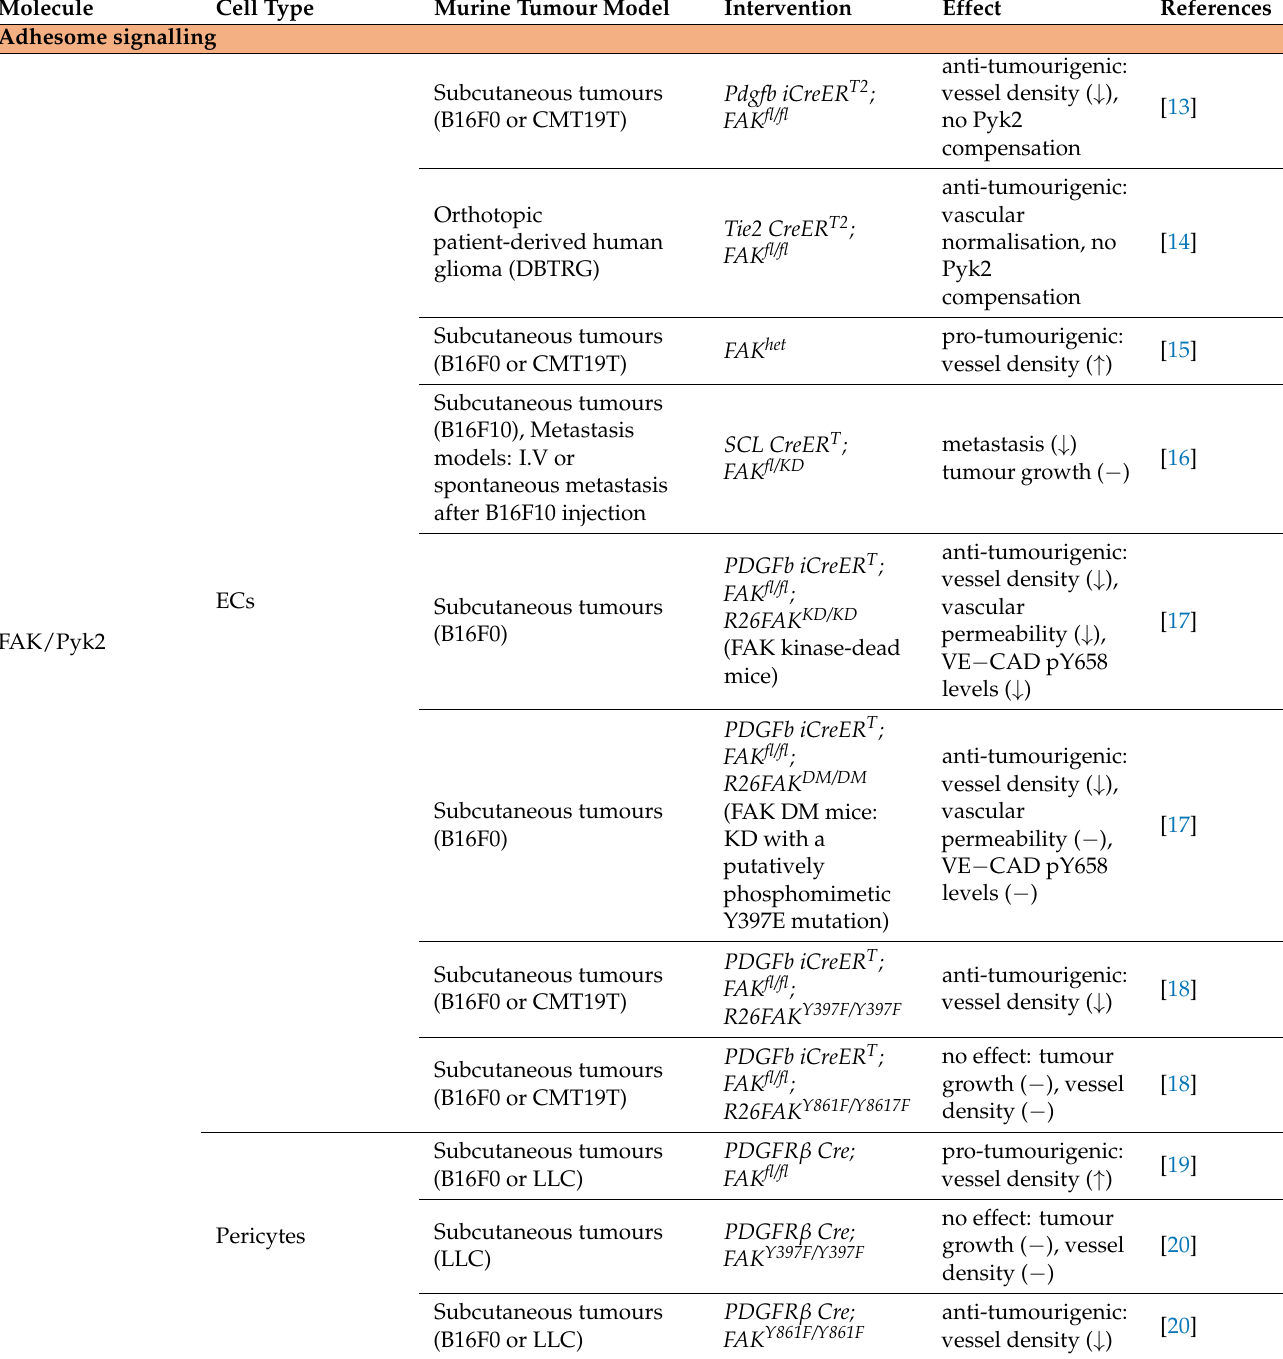
Table 1. Adhesome and cancer: in vivo studies investigating the effect of genetic deletion or pharmacological inhibition of adhesome members in specific tumour stroma cell